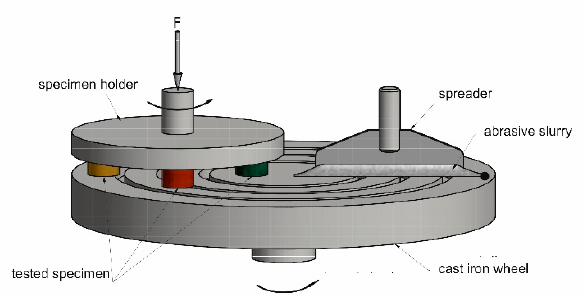
Figure 2. Schematic representation of the 3-body abrasive wear testing facility.